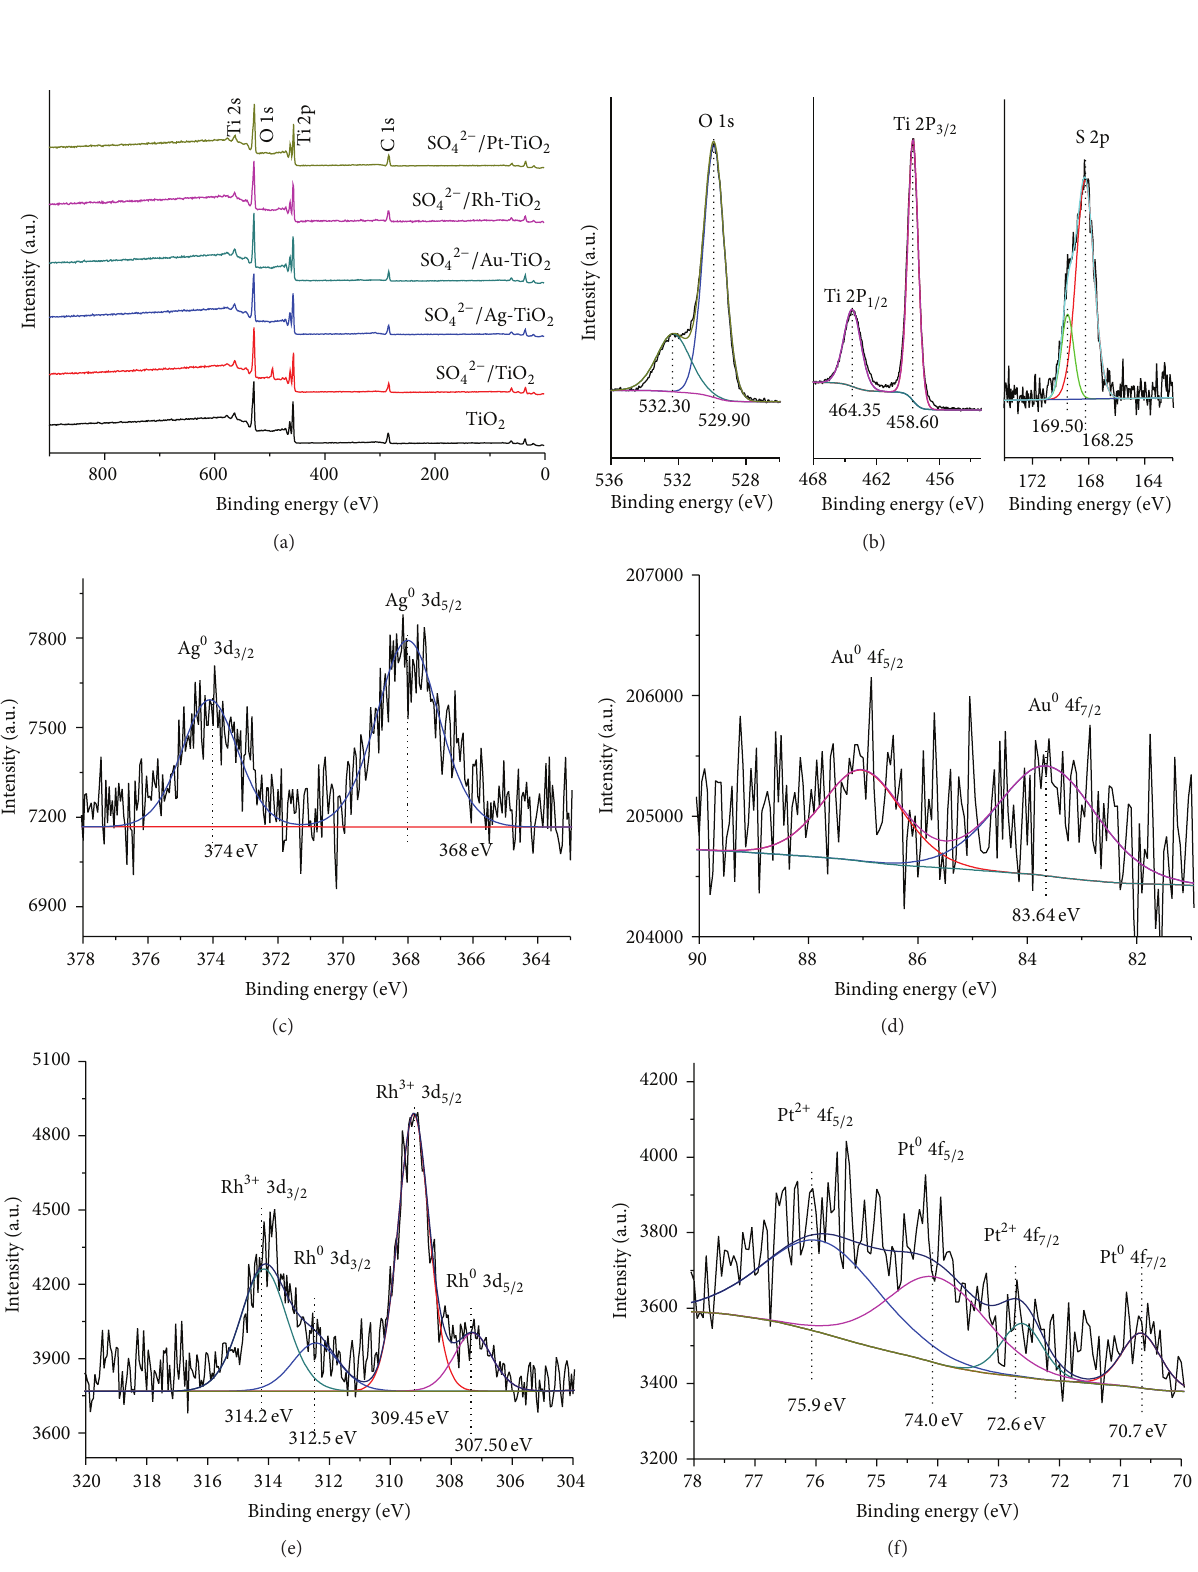
Figure 5: XPS (a) spectra of samples, (b) O 1s, Ti 2p, and S 2p peaks of SO 42− /M-TiO 2 samples, (c) Ag 3d spectra of SO 42− /Ag-TiO 2 sample, (d) Au 4f 3d spectra of SO 42− /Au-TiO 2 sample, (e) Rh 3d spectra of SO 42− /Rh-TiO 2 sample, and (f) Pt 4f spectra of SO 42− /Pt-TiO 2